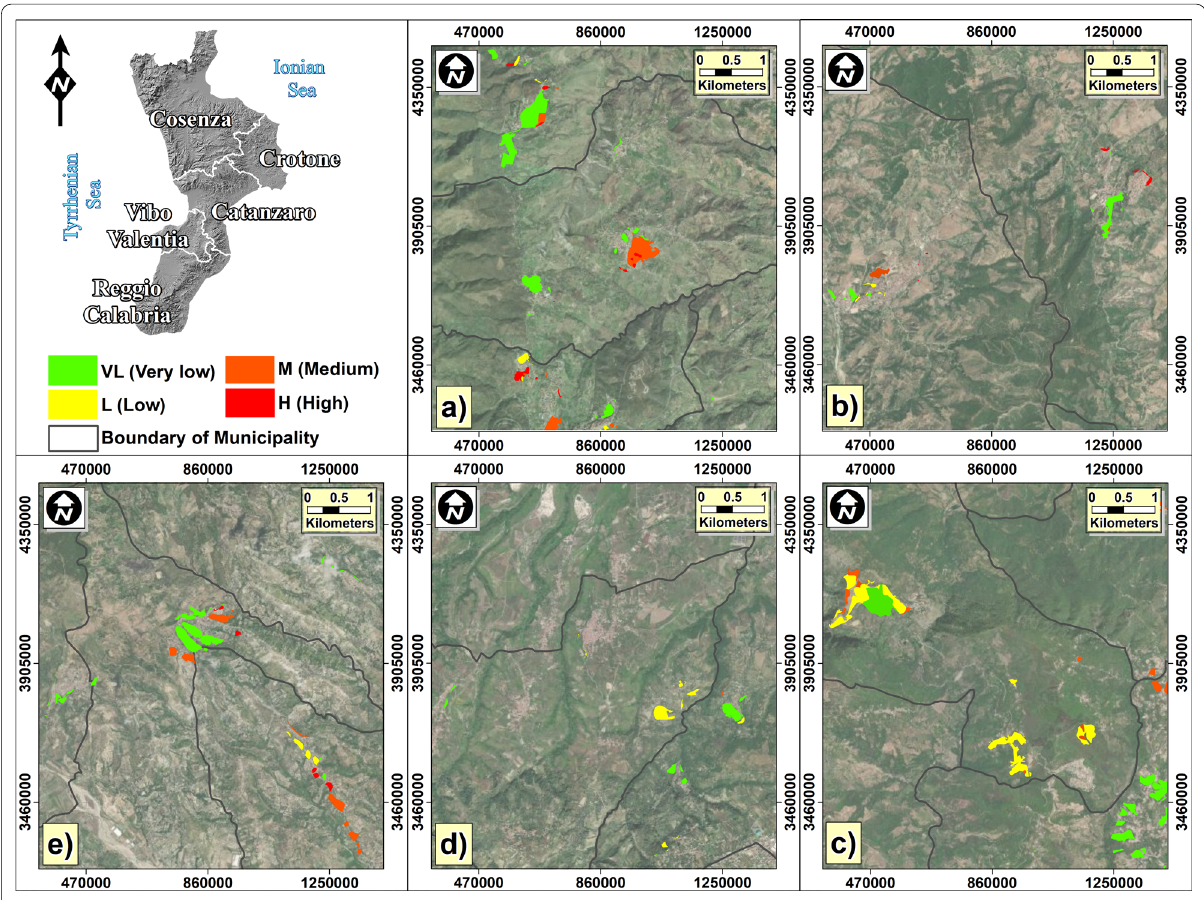
Fig. 12 An example of VAs distinguished according to the results of the Slope consistency matrix . The sample areas correspond to the ones identified in Fig. 8 (white boxes) for the Provinces of: a Cosenza, b Crotone, c Catanzaro, d Vibo Valentia and e Reggio Calabria